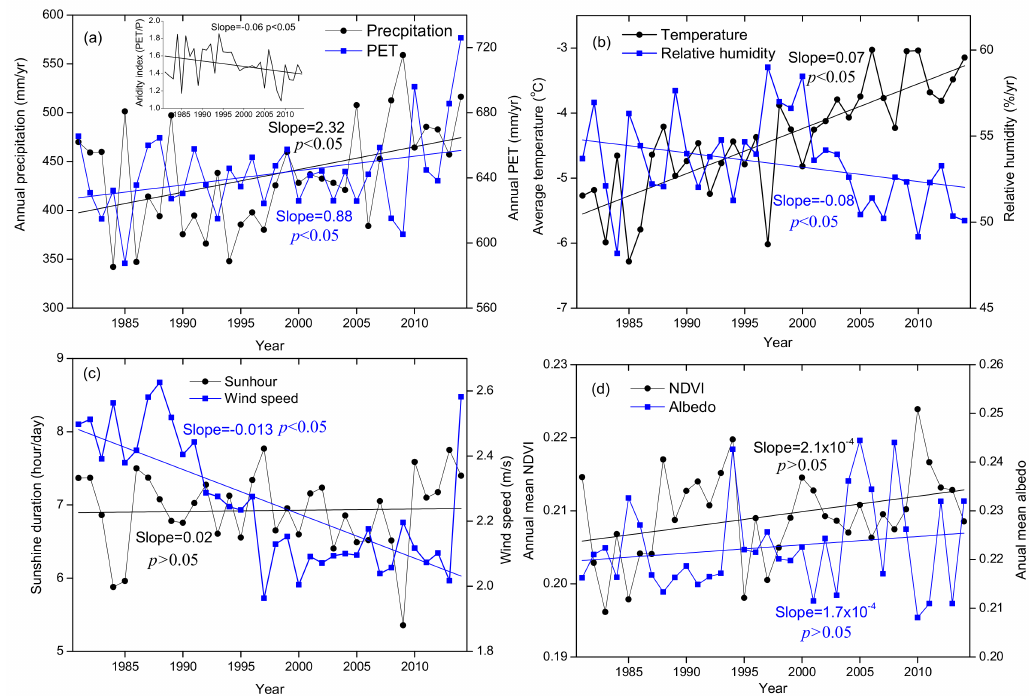
Figure 5. Interannual variability and trends in climatic and vegetation properties across the study basin during the period 1981–2014. In each panel, the slope of the fitted line indicates the trend in time series, and the trend is statistically significant when the p -value is less than 0.05. The subfigure in Figure 4a presents the variation of annual aridity index (PET / P) during the period 1981–2014.